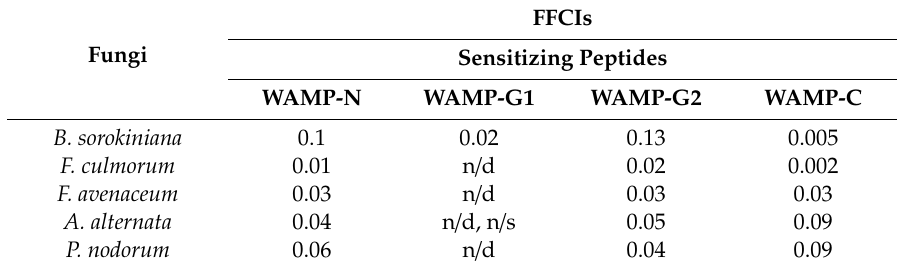
Table 4. Synergism-confirming values of Fractional Fungicidal Concentration Indices (FFCIs) in e ff ective tebuconazole–WAMP-2 fragment